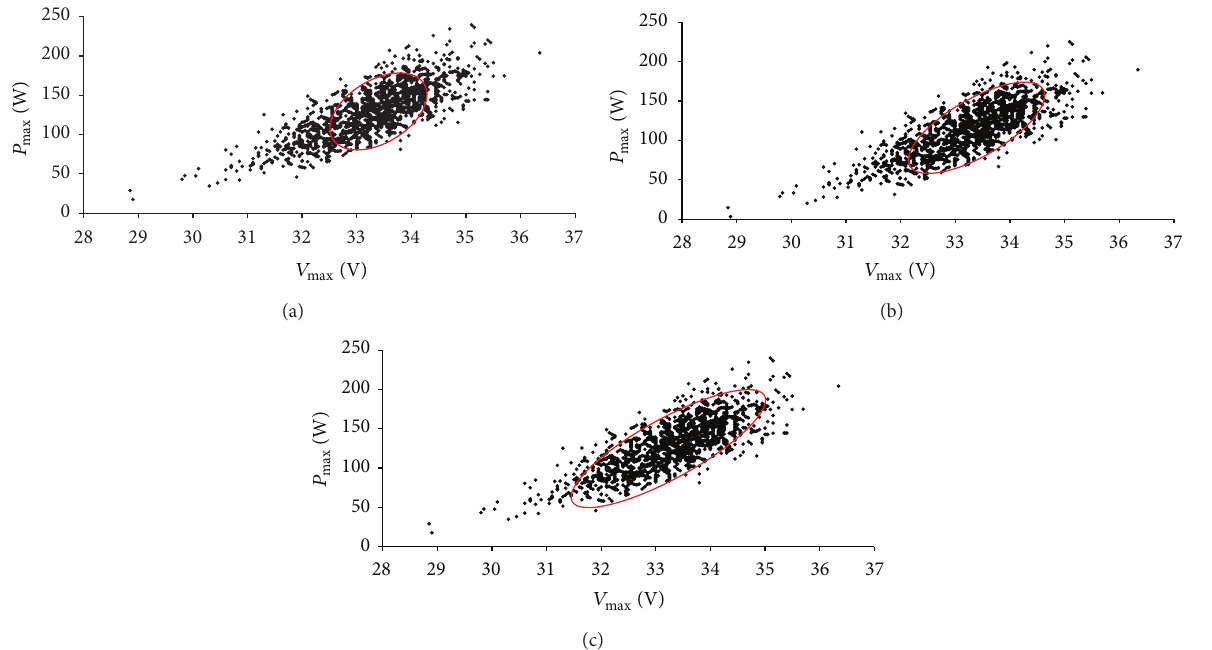
Figure 7: Different size of elliptical hitting zone superimposed on the plot of simulated ( 𝑉 data: (a) 37.2% of the MPPs involved, (b) 68.5% of the MPPs involved, and (c) 85.5% of the MPPs involved.